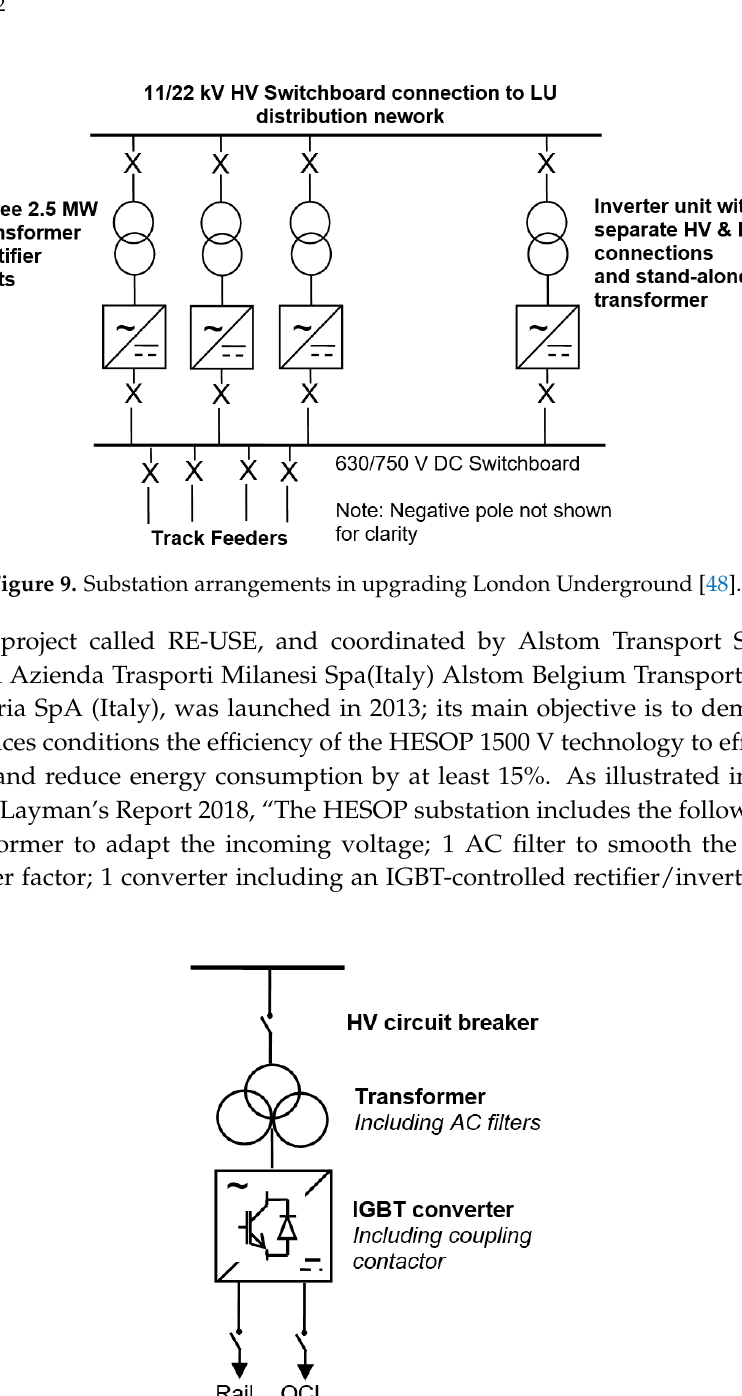
Figure 8. Structure of the active substation with direct return [117].